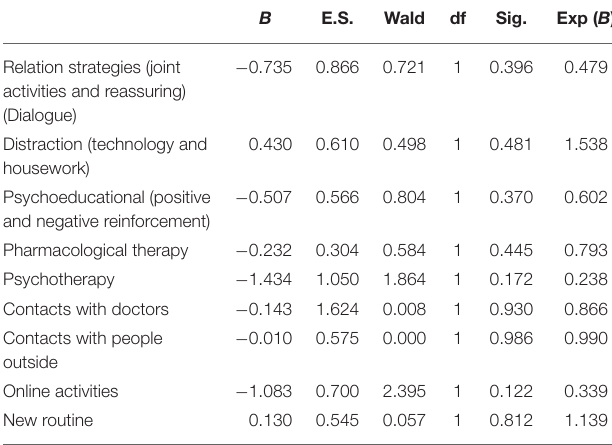
TABLE 12 | Regression between positive factors and not onset of new symptoms (section III-IV).